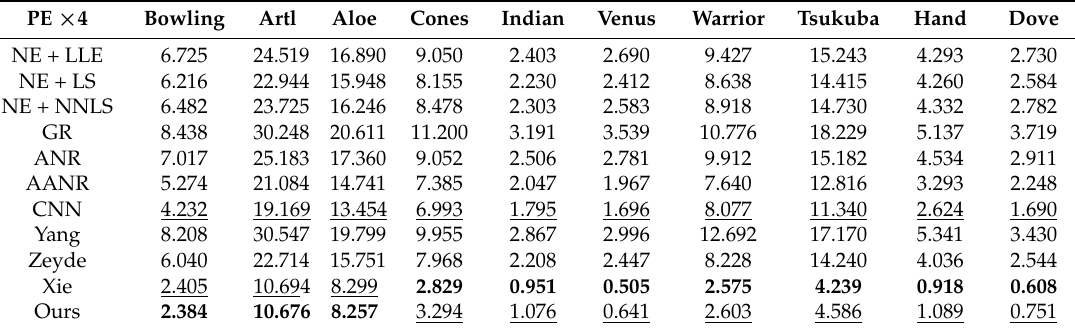
Table 4. PE values on the Middlebury Stereo database with scaling factor of 4.